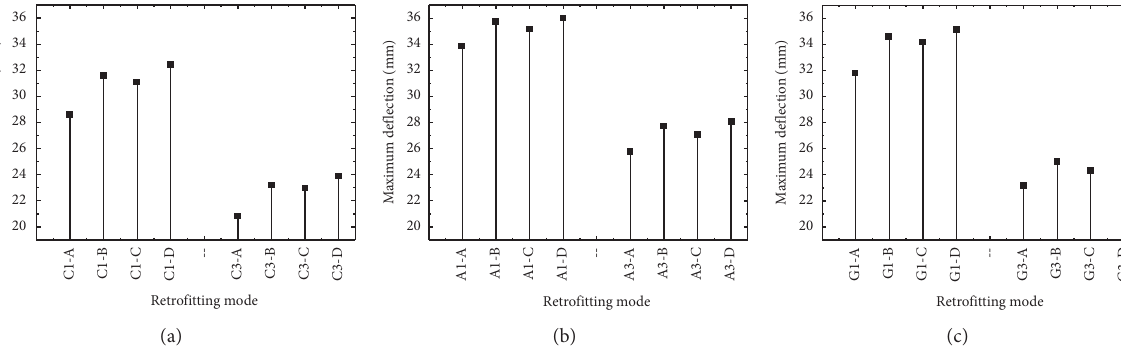
Figure 15: Maximum deflection of the columns retrofitted with different modes. (a) CFRP. (b) AFRP. (c)